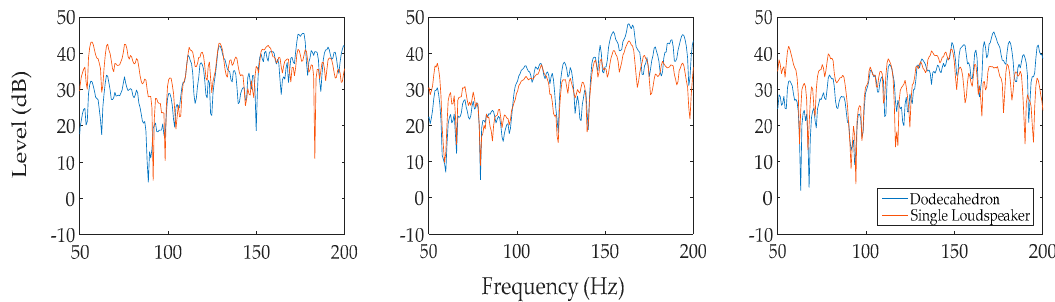
Figure 10. Frequency responses for measurements with the dodecahedron speaker and the proposed method for point A, B and C in the amphitheater (from left to right respectively).